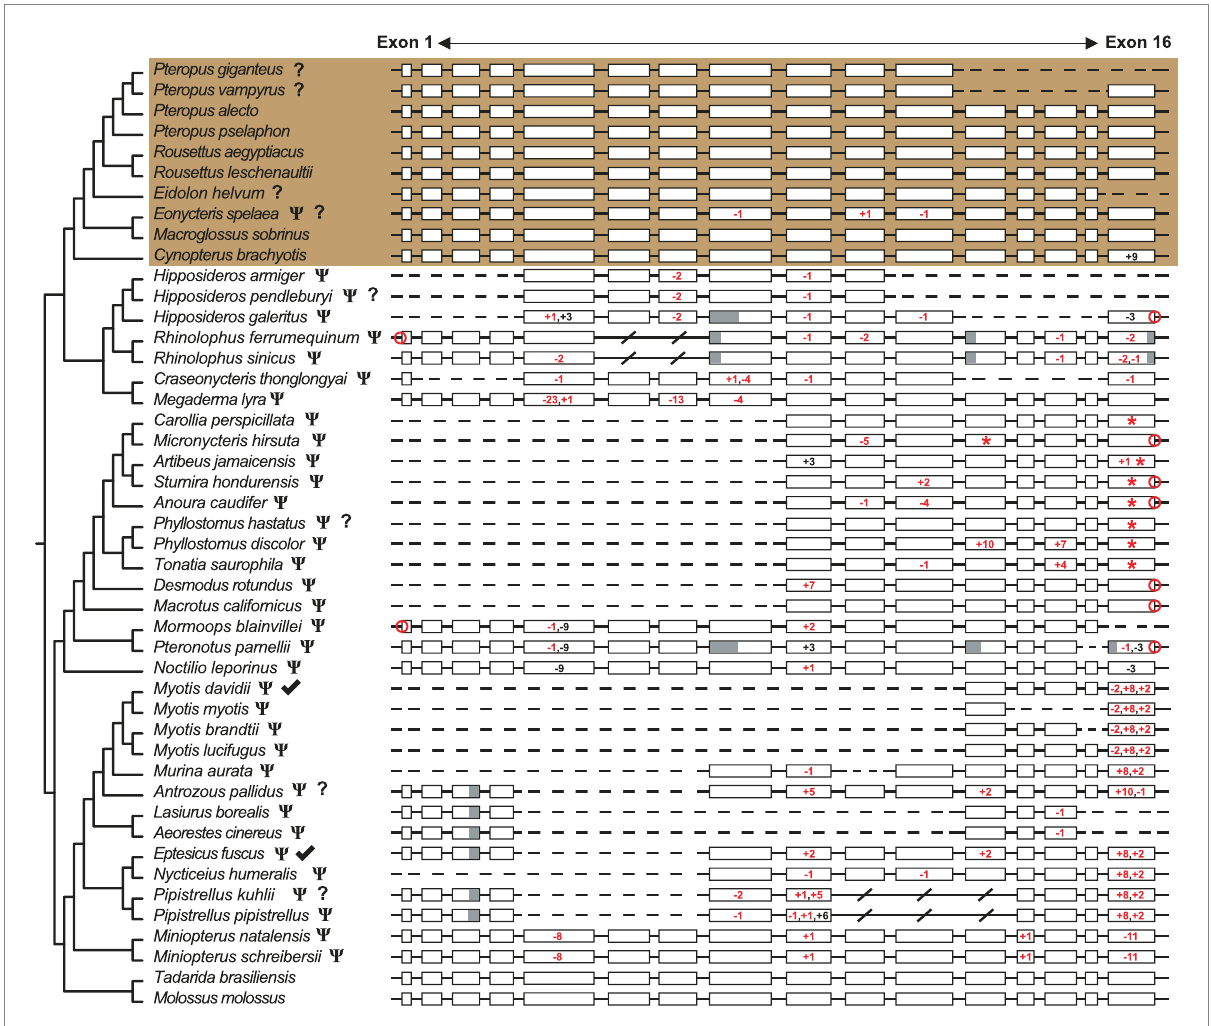
FIGURE 1 Pseudogenization of ARR3 in bats. Coding sequences of ARR3 in both non-echolocating Old World fruit bats (brown background) and echolocating bats. Pseudogenes verified by examining raw sequencing data are shown as “ Ψ ,” whereas potential pseudogenes without verification evidence are shown as “ Ψ ?” and sequence of uncertain status as indicated by “?”. Reported pseudogenes are indicated by checkmarks (Indrischek et al., 2022). Lengths of indels in exons are indicated by the black and red (frame-shifting) numbers, with “–” indicating deletion and “+” insertion. Red asterisk (*) indicates location of pre-mature stop codon. Losses of start or stop codons are indicated by red circles. Missing regions of partial exons are shown in gray and completely missing exons are indicated by “/”. Sequencing assembly gaps are shown as dashed